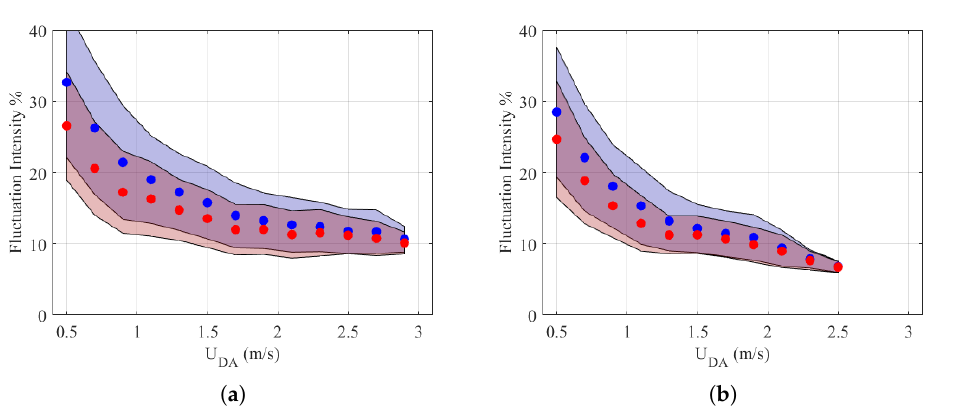
Figure 7. Variation of fluctuation intensity at each near surface hub height for each site location, with solid markers showing the mean and shaded region given to show the range around the mean, blue band/blue markers—all samples, red band markers—without wave cases. ( a ) Location A. ( b ) Location